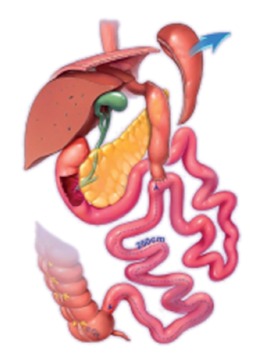
Diagram of the single anastomosis duodenoileal bypass with sleeve
gastrectomy